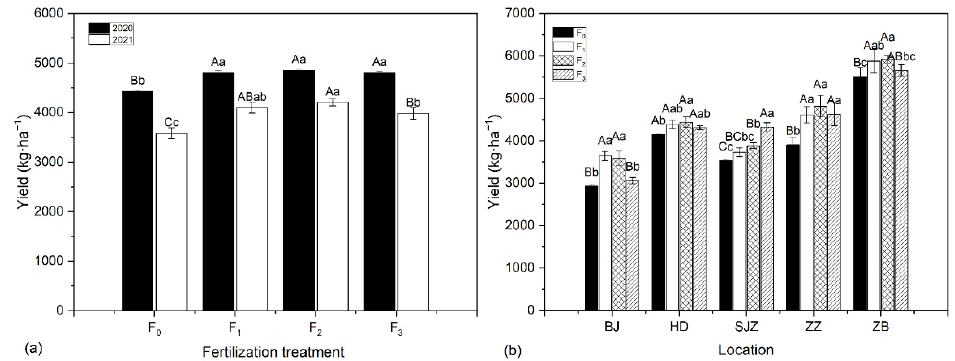
Figure 6. Effects of fertilizer–year ( a ) and fertilizer–location ( b ) on yield. Different lowercase and uppercase letters on columns indicate the results are significantly different at p < 0.05 and p < 0.001 according to LSD test, respectively.